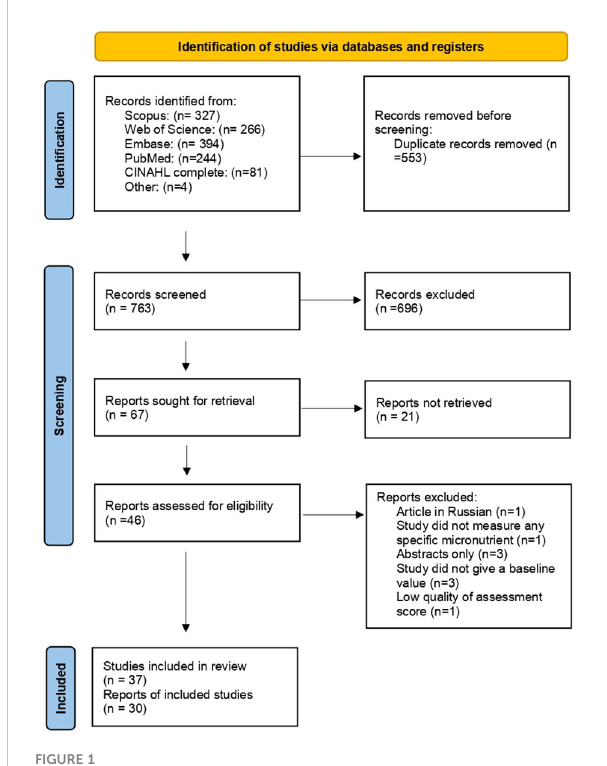
FIGURE 1 The PRISMA fl ow chart of screening and study